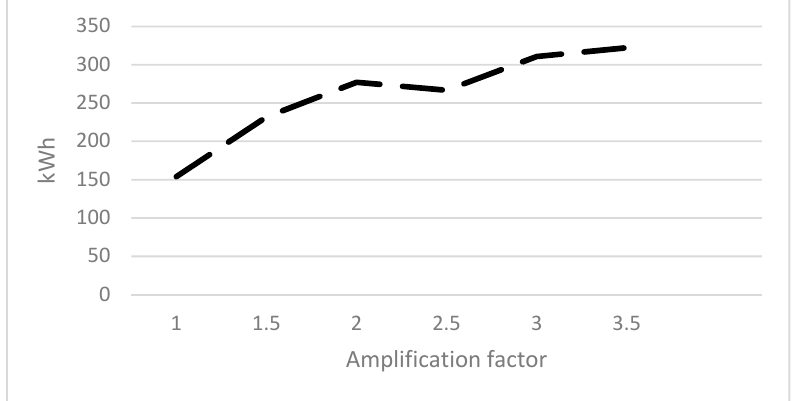
Figure 6. Battery size measured in kWh as a function of different demand levels presented by an amplification factor. Amplification factor 1 means the current situation, while 2 refers to a situation where demand (as associated with the arrival rate in each hour) is doubled.